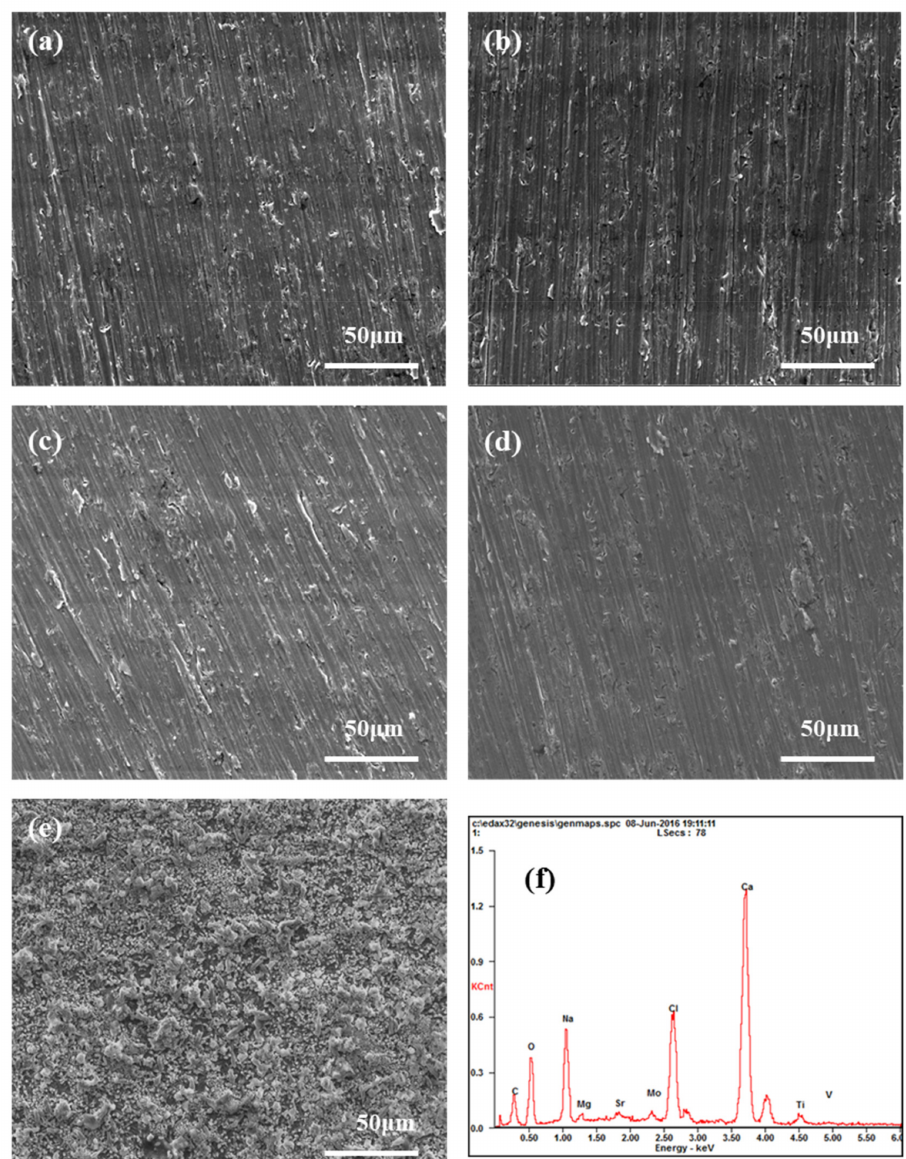
Figure 10. Microscopic morphology of TA2 in simulated seawater solution with different pH values: before removing the sedimentation layer. ( f ) EDS spectrum corresponding to analysis of the area indicated by the red box in ( e